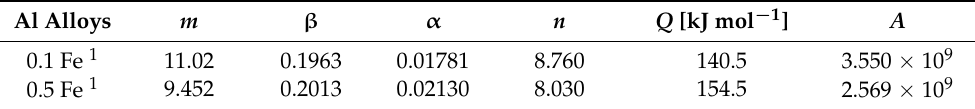
Table 3. Comparison between the predicted peak stresses ( σ P ( pre ) ) and experimental peak stresses . ε ( σ P ( exp ) ) at the investigated strain rates ( N ) of the two Fe-containing Al alloys. . ε − 1 ] Alloys N [s